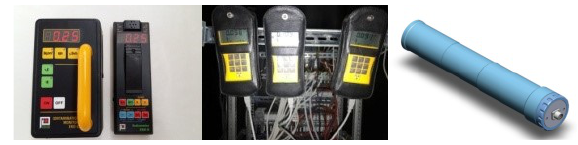
Figure 2. Left: EKO-C and EKO-D dosimetry probe. [6]. Cen- ter: Gamma-Scout dosimetry probe. Right: UM-EGM wide range gamma probe. [7, 8]